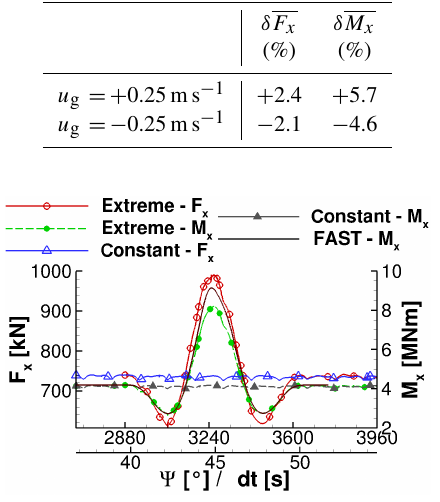
Figure 5. Rotor thrust F x and torque M x during the